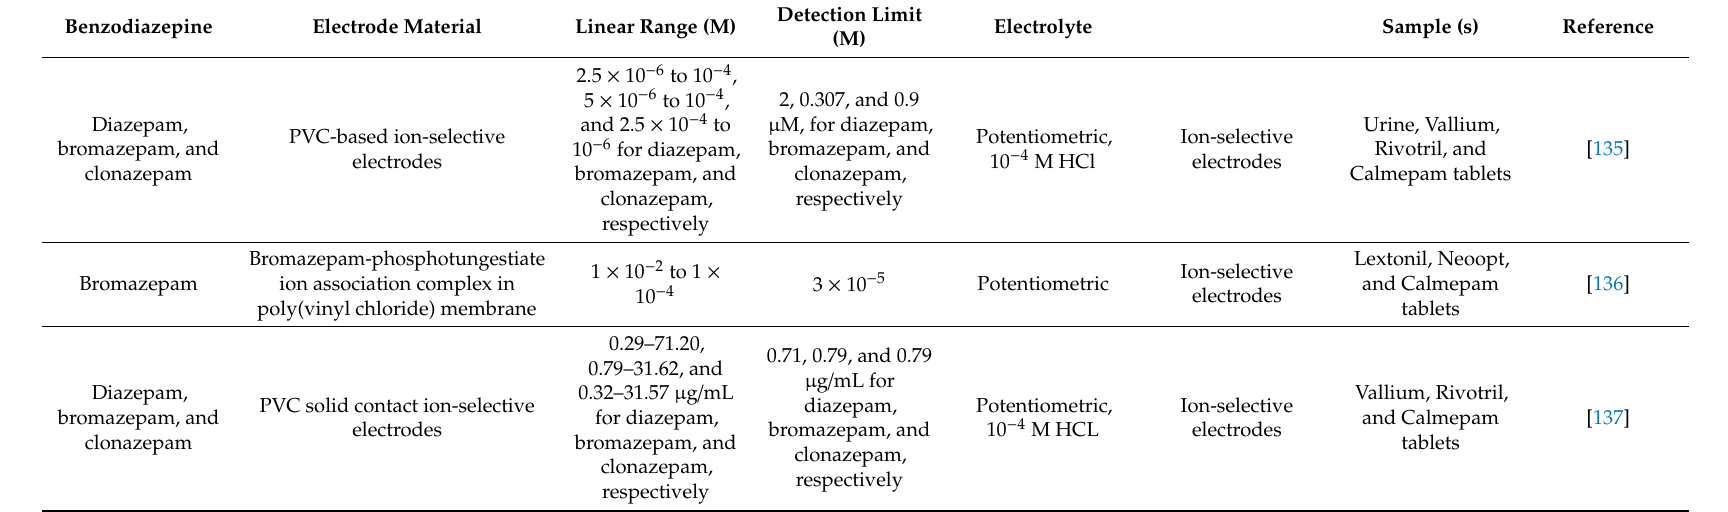
Table 3. Ion-selective electrodes for the determination of